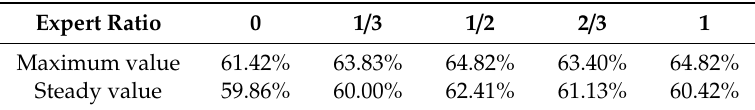
Figure 21. Full expert-driven learning.